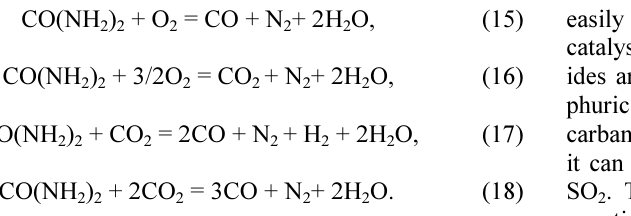
Fig. 3. The Gibbs’ energy value change dependency on temperature during reactions between carbamide and CO 2 and air oxygen according to the equations presented in the